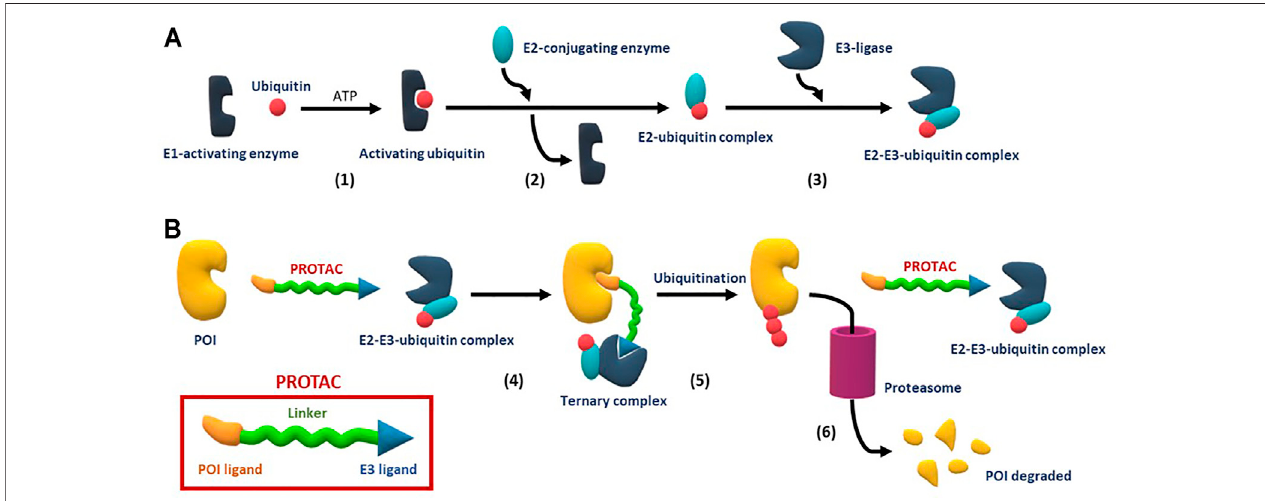
FIGURE1| RepresentationofPROTACsstructure(seeinsetredbox),interactors,andmechanismofaction. (A) Ubiquitinationprocess:(1)Ubiquitinisactivatedby an E1-enzymatic protein in an ATP-dependent process, (2) the activated ubiquitin is transferred to a E2-conjugating enzyme, (3) the target protein is joined to the E2- ubiquitin via an E3-ligase enzyme, giving rise to an E2-E3-ubiquitin complex; (B) Mechanism of action of PROTACs divided into three steps: PROTACs are able to approach the protein of interest and the E3/E2/Ub complex forming ternary complexes (4), which allows the E3/E2/Ub complex to transfer ubiquitins to the target proteins (5) which, once tagged, are recognized by the proteasome for degradation (6).